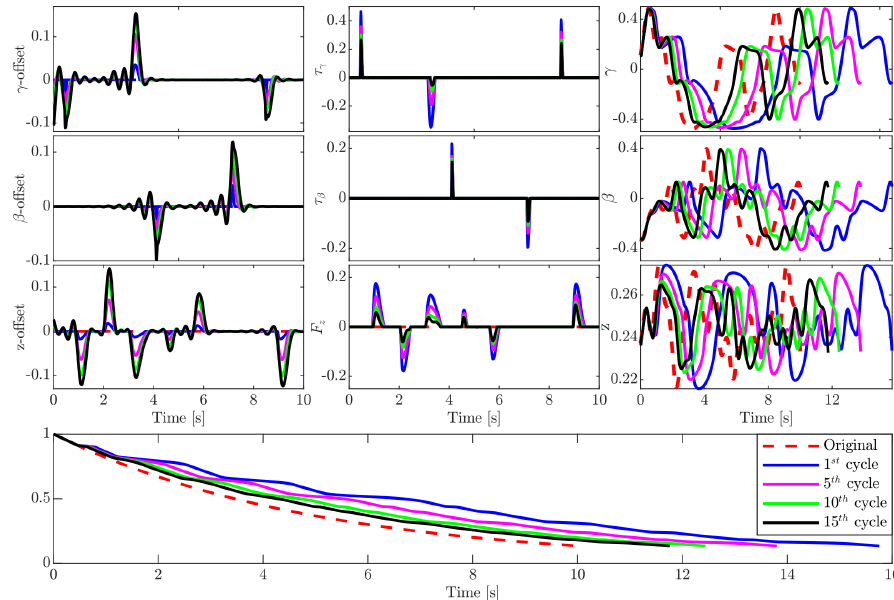
Figure 10. Adaptation for a three-df exercise. Left-column : increase of learned offset over 15 cycles. Middle-column : force adaptation. Right-column : exercise trajectory adaptation. Bottom : phase